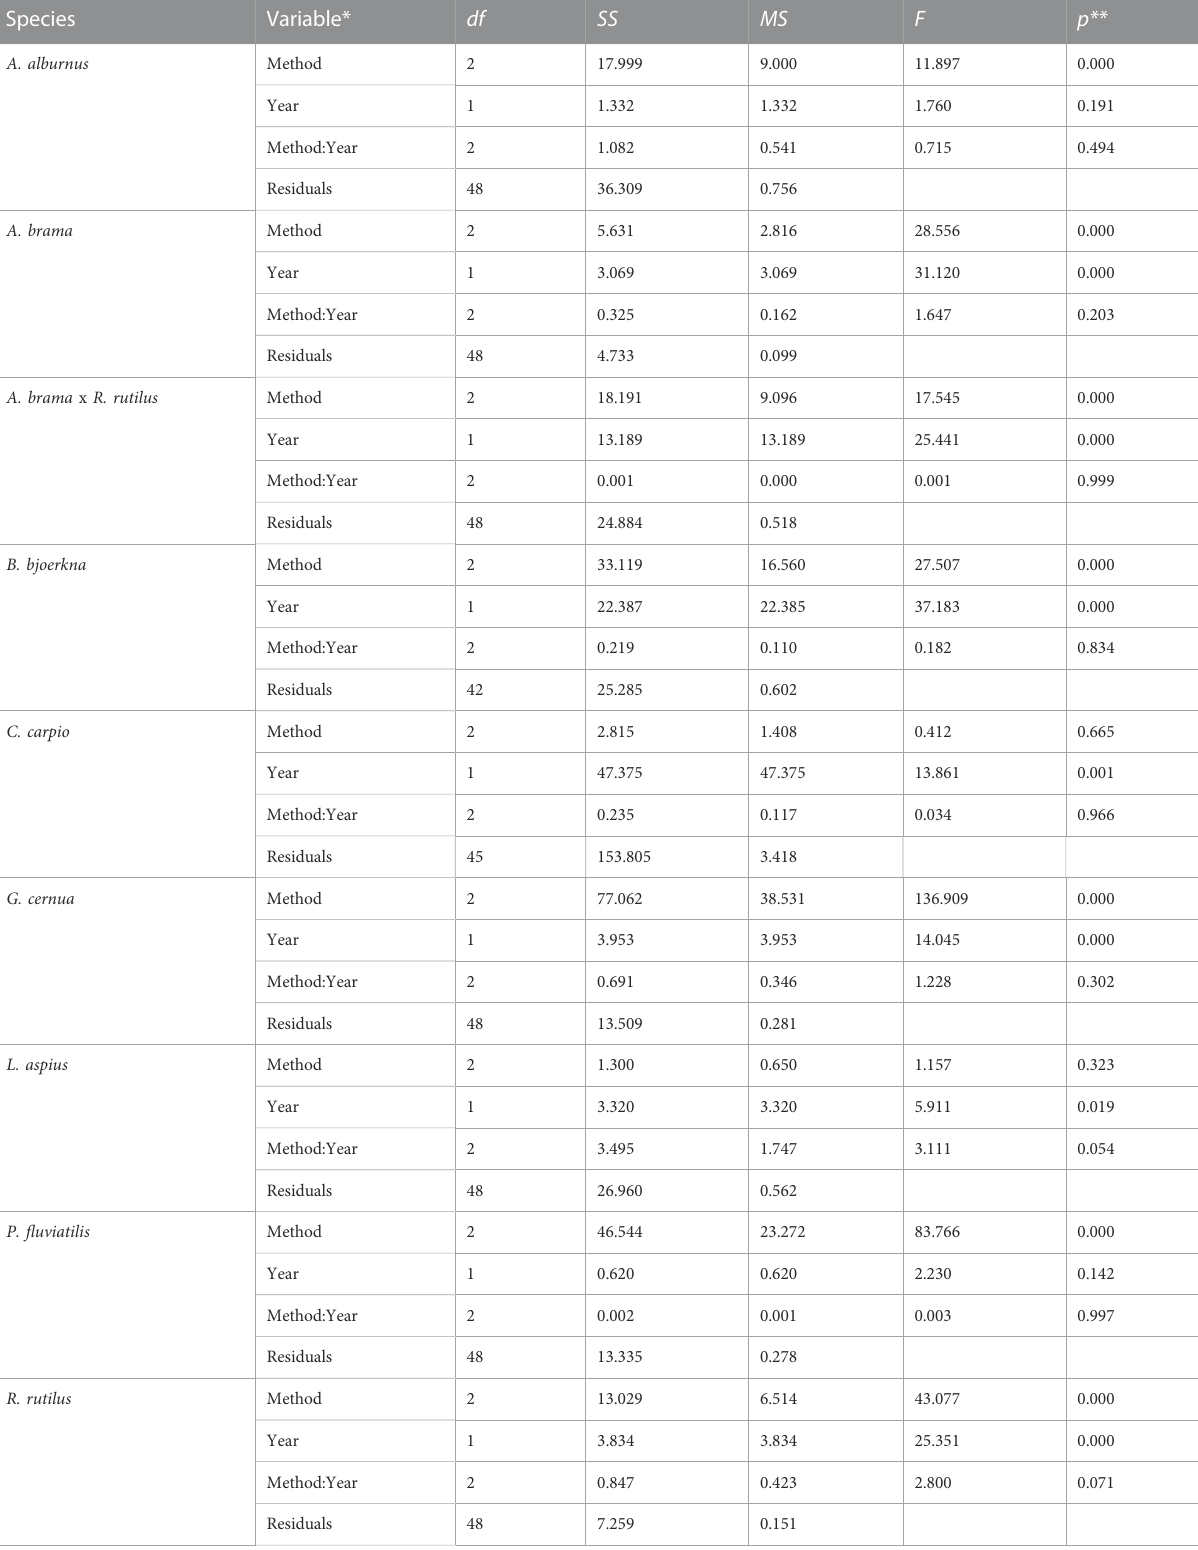
TABLE 5 ANCOVA results of the interaction test for BPUEs of the dominant species and the whole community sampled from 2004 to 2021 in Ř ímov Reservoir, Czech Republic.